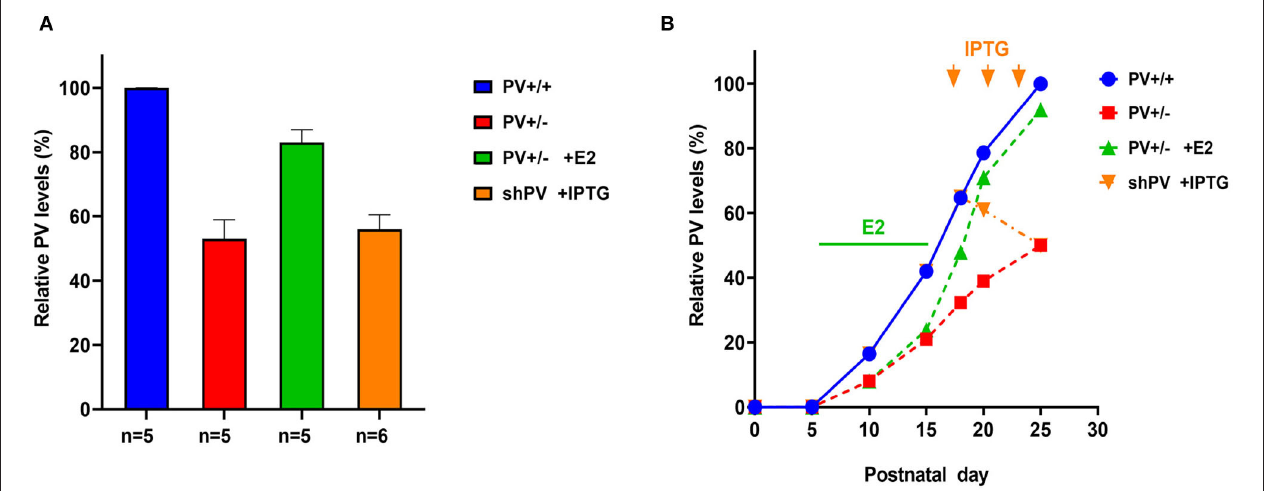
FIGURE 2 | (A) Relative parvalbumin (PV) expression level determined by semi-quantitative western blot analysis in mouse forebrain extracts from PND25. Data for PV + / + (defined as 100%), PV + / − , and PV + / − mice treated with E2 are from Filice et al. (2018); data for isopropyl- β - D -thiogalactoside (IPTG)-treated shPV mice are from Filice et al. (2019). The number of mice is indicated; values represent mean ± SD. (B) Autism spectrum disorder (ASD)-like behavior shown in Figures 3 , 4 was tested at PND25 in four conditions/genotypes: (1) wild-type (WT) mice; (2) constitutive PV + / − mice; (3) PV + / − rescue mice, in which PV expression was enhanced by E2 treatment; and (4) shPV22 (downregulation) mice, in which IPTG treatment at PND18, PND21, and PND24 reduced PV level to 50–60% of that in WT mice at PND25. PV expression profile (solid blue line) in WT (PV + / + ) mice is based on data obtained from protein extracts of mouse cerebellum ( Collin et al., 2005). In PV + / − mice (red line), the level was assumed to be ∼ 50% that of WT mice at all time points. Treatment of PV + / − mice with E2 from PND5 to PND15 (green bar) results in a PV level that is ∼ 90% of that in WT mice at PND25 (green line). Treatment of transgenic shPV22 mice with IPTG at PND18, PND21, and PND24 (orange arrows) decreases PV level to ∼ 50% of that in WT mice at PND25 (orange line). As the precise course of PV expression in the three groups is not yet supported by experimental data, the lines are dashed. However, relative PV expression level at PND25 corresponds to the experimental data shown in (A) . As previously reported, IPTG treatment alone